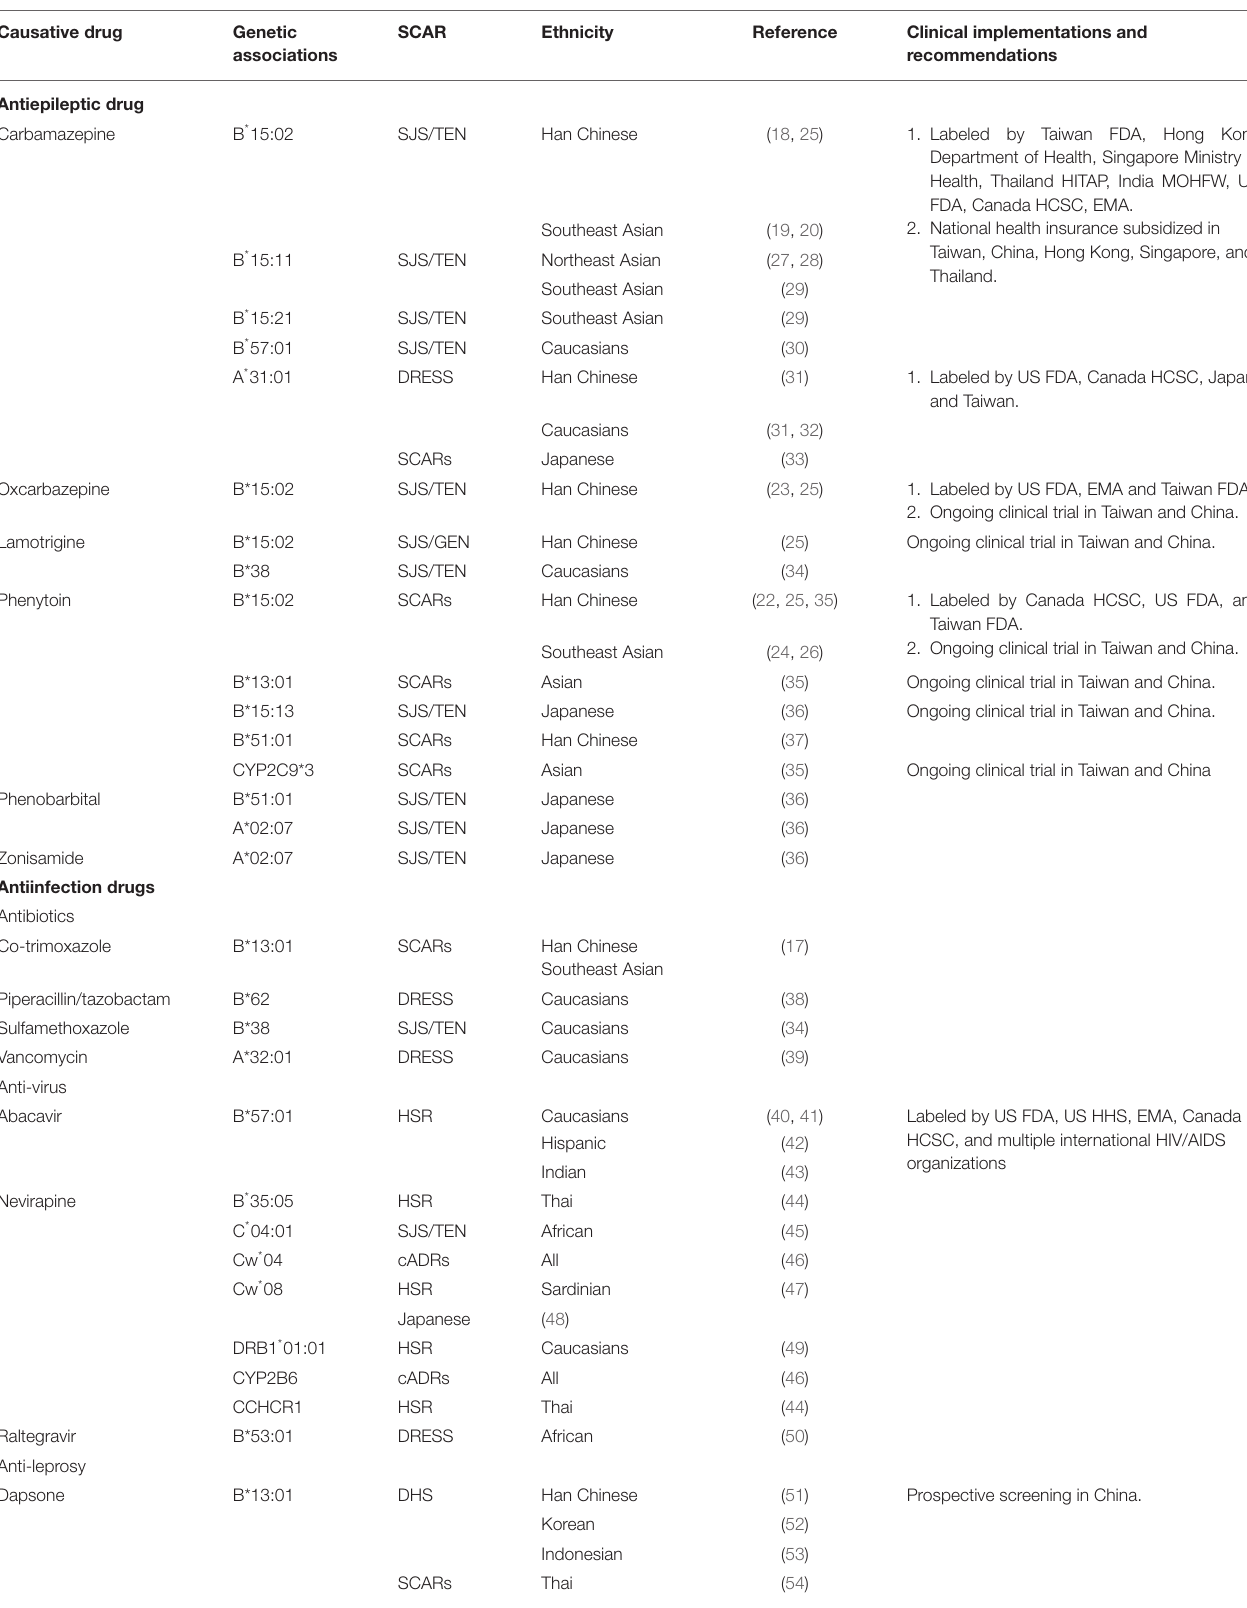
TABLE 1 | Genetic associations with SCARs in different populations. Causative drug Genetic associations